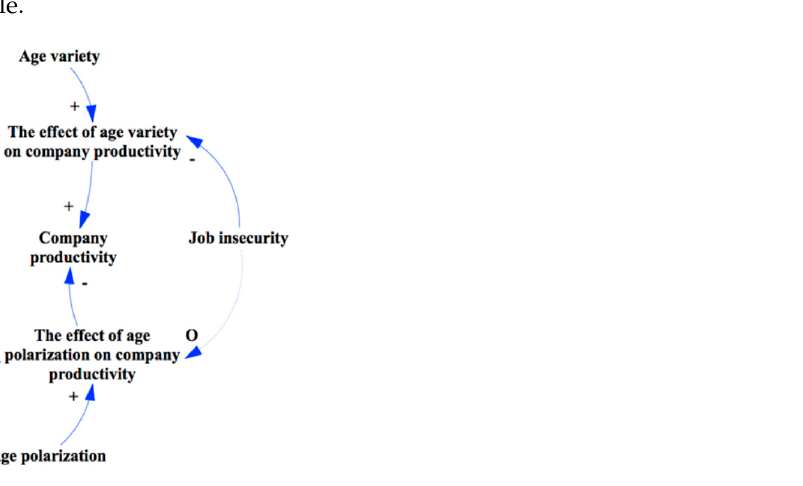
Figure 5. Authors drawing of the causal relationships from the results of De Meulenaere et al. (2016).